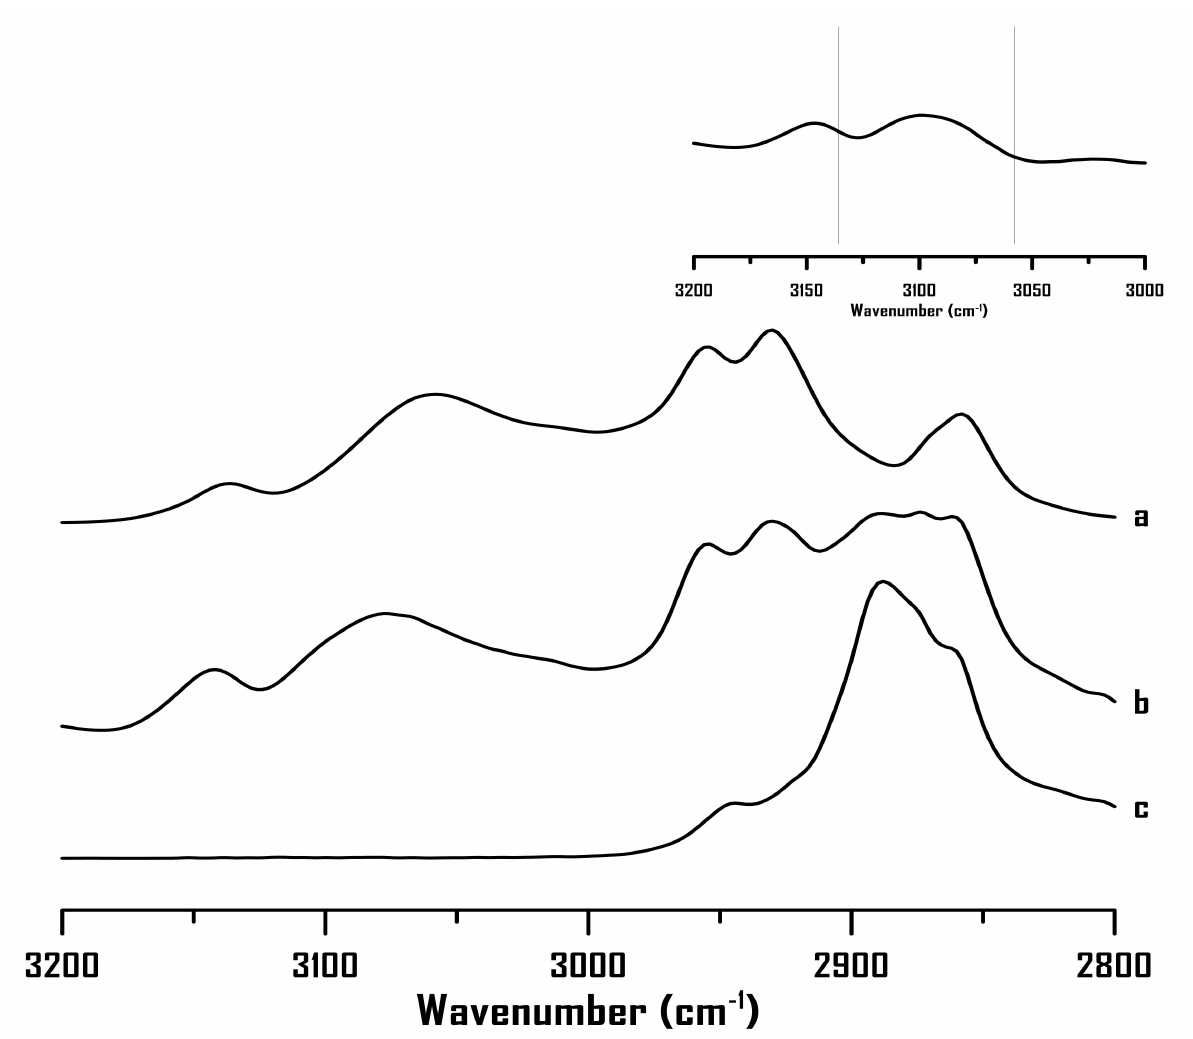
Figure 6. IR spectra of ( a ) pure [HMIM]Br, ( b ) mixture of PEO containing 75 wt% [HMIM]Br, and ( c ) pure PEO at ambient pressure. Upper-right corner: the difference spectrum